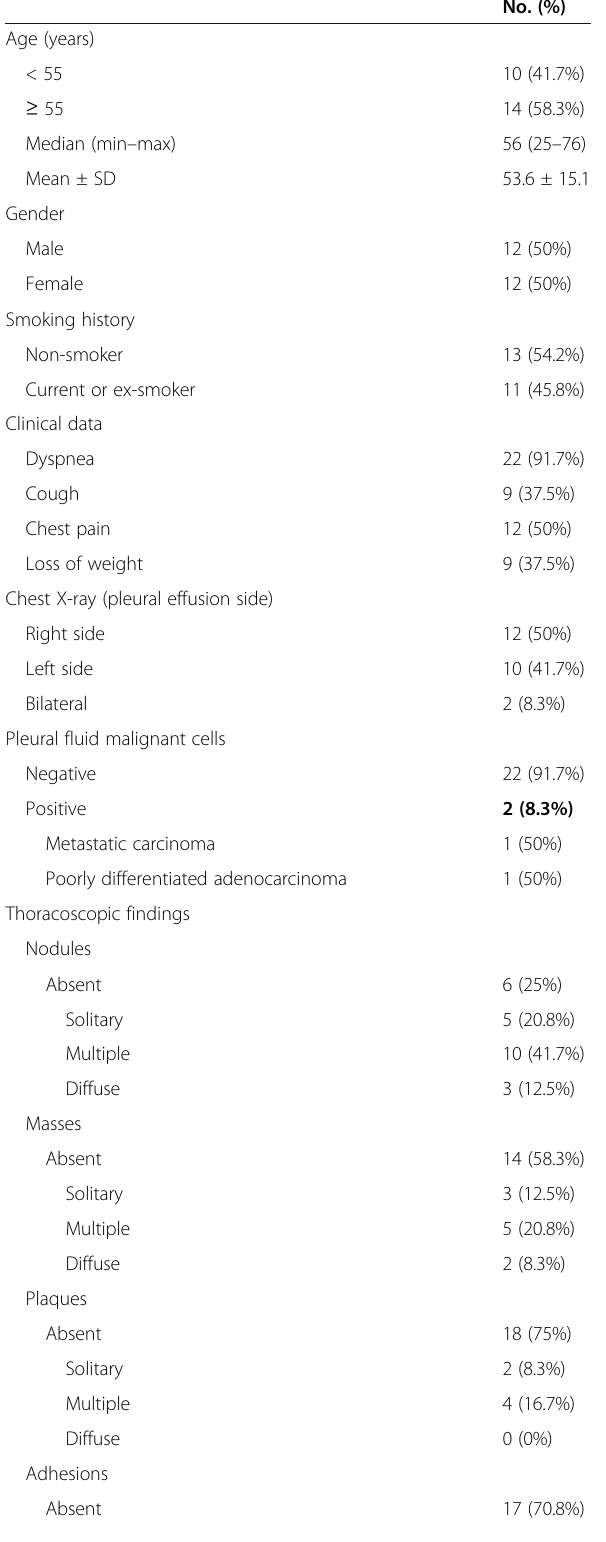
Table 1 Demographic data, clinic-radiologic, and thoracoscopic findings of the studied patients ( n = 24)